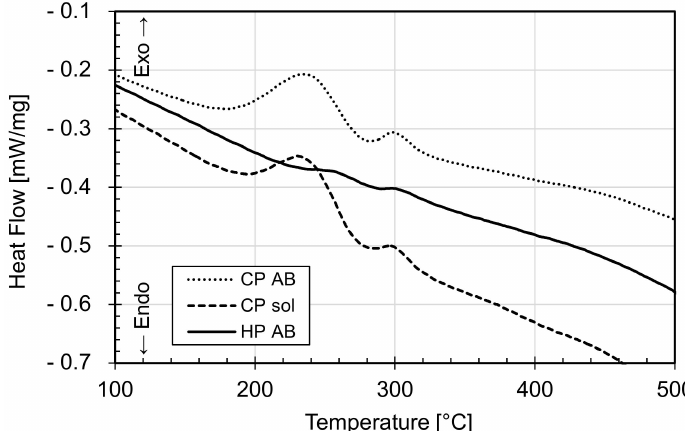
Figure 6. DSC scan profiles collected on heating of the SLM-processed AlSi10Mg alloy within the temperature range of interest for the precipitation of the strengthening phases.